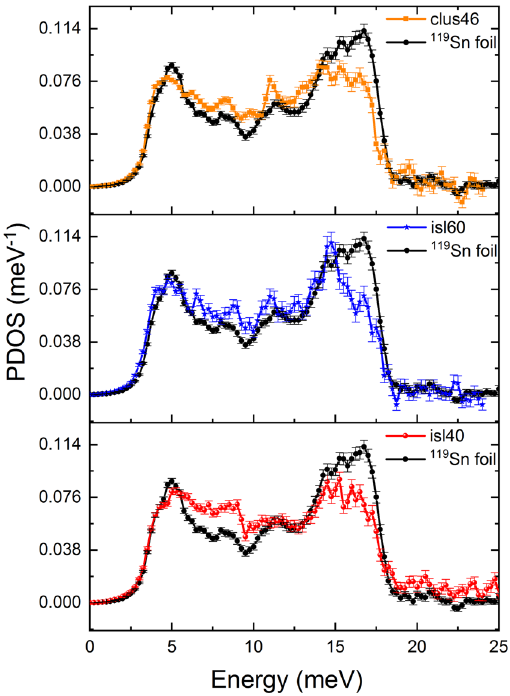
Figure 5. Phonon density of states for the Sn cluster-assembled film and the Sn island samples in comparison to bulk Sn. Data have been reproduced with permission from 32